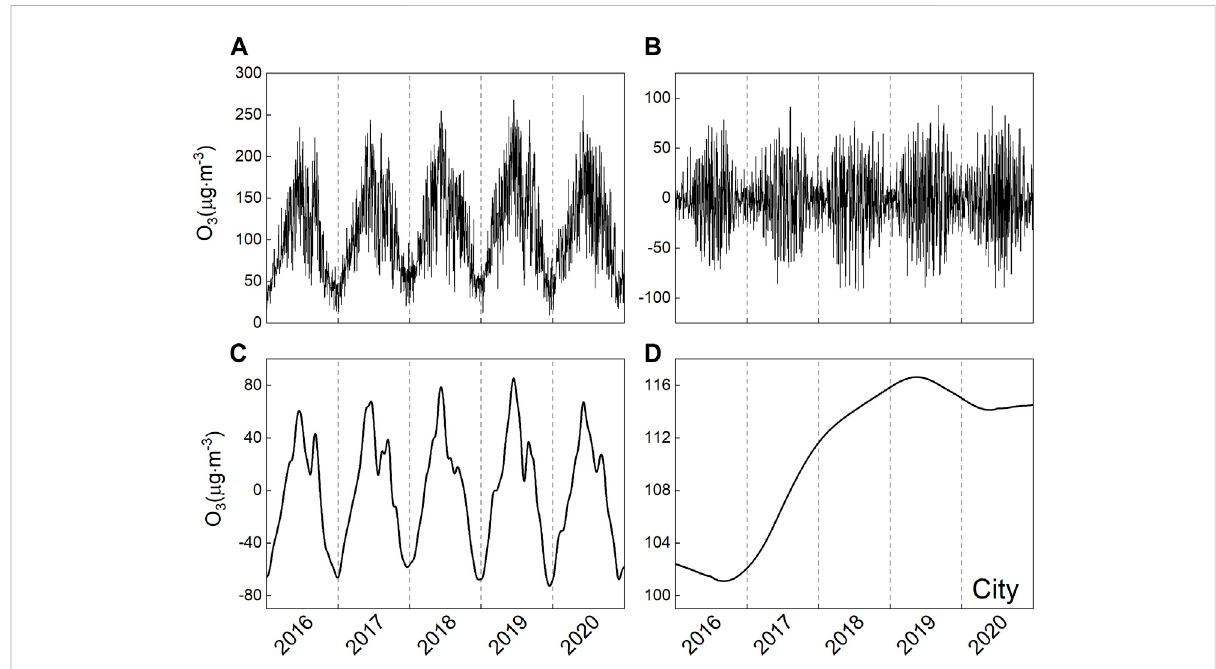
FIGURE 3 Separated time series of MDA8 of the ozone values during 2016 – 2020. (A) the original data; (B) the short-term component; (C) the seasonal component; (D) the long-term